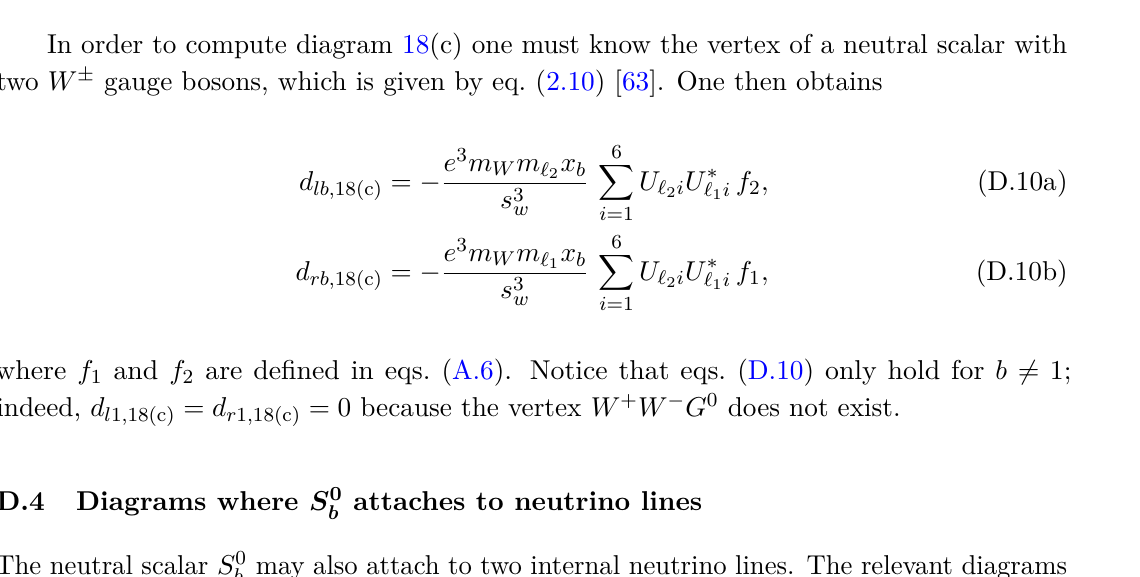
where S 0 attaches to → ‘ + ‘ − 1 2 b b